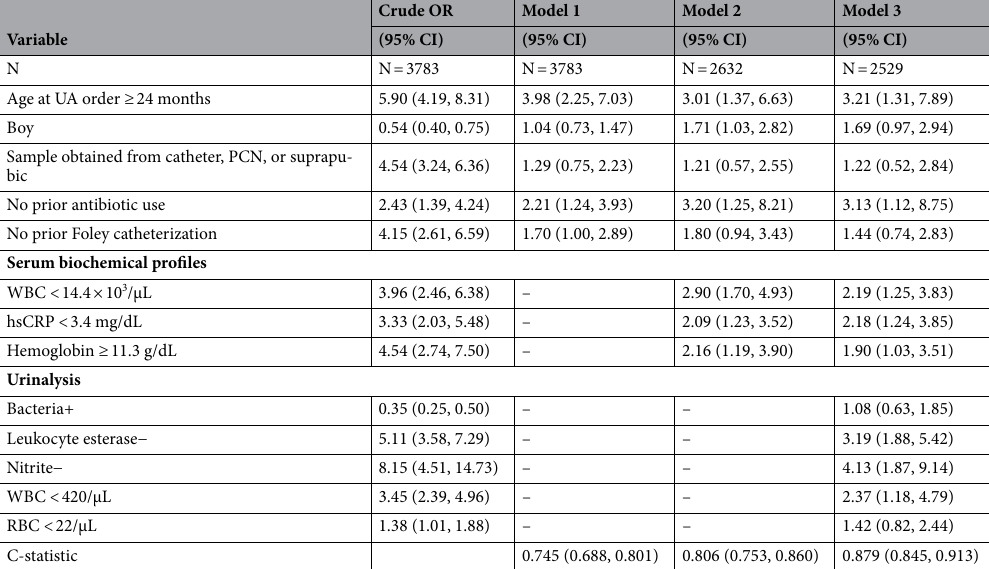
Table 2. Multivariable logistic regression model for predicting pediatric urinary tract infections caused by gram-positive bacteria. CI confidence interval, hsCRP high sensitivity C-reactive protein, OR odds ratio, PCN percutaneous nephrostomy, RBC red blood cell, UA urinalysis, WBC white blood cell.